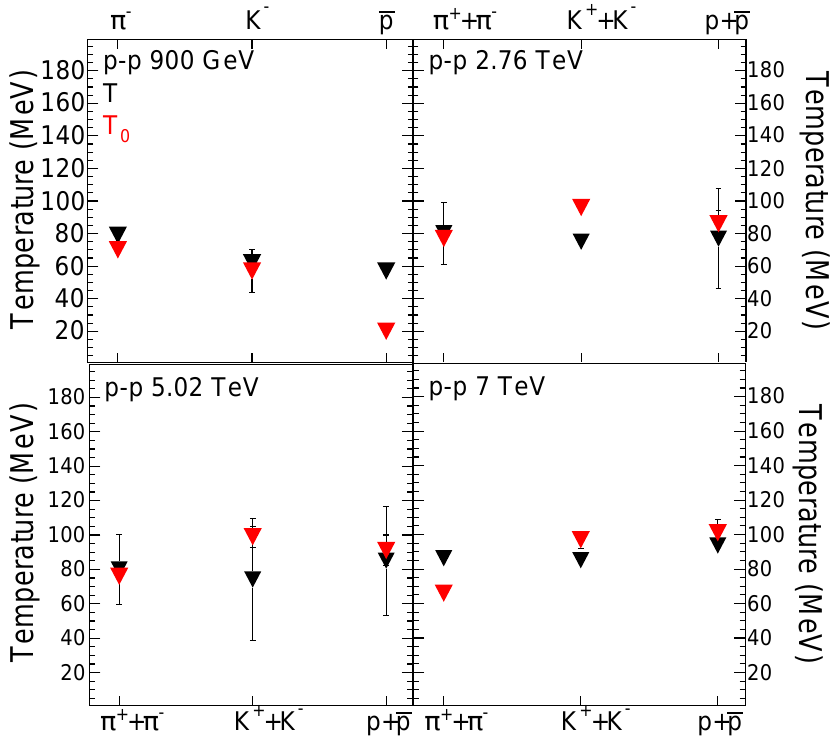
Figure 1. A comparison of the values of temperatures T and T 0 of different hadron species for pp